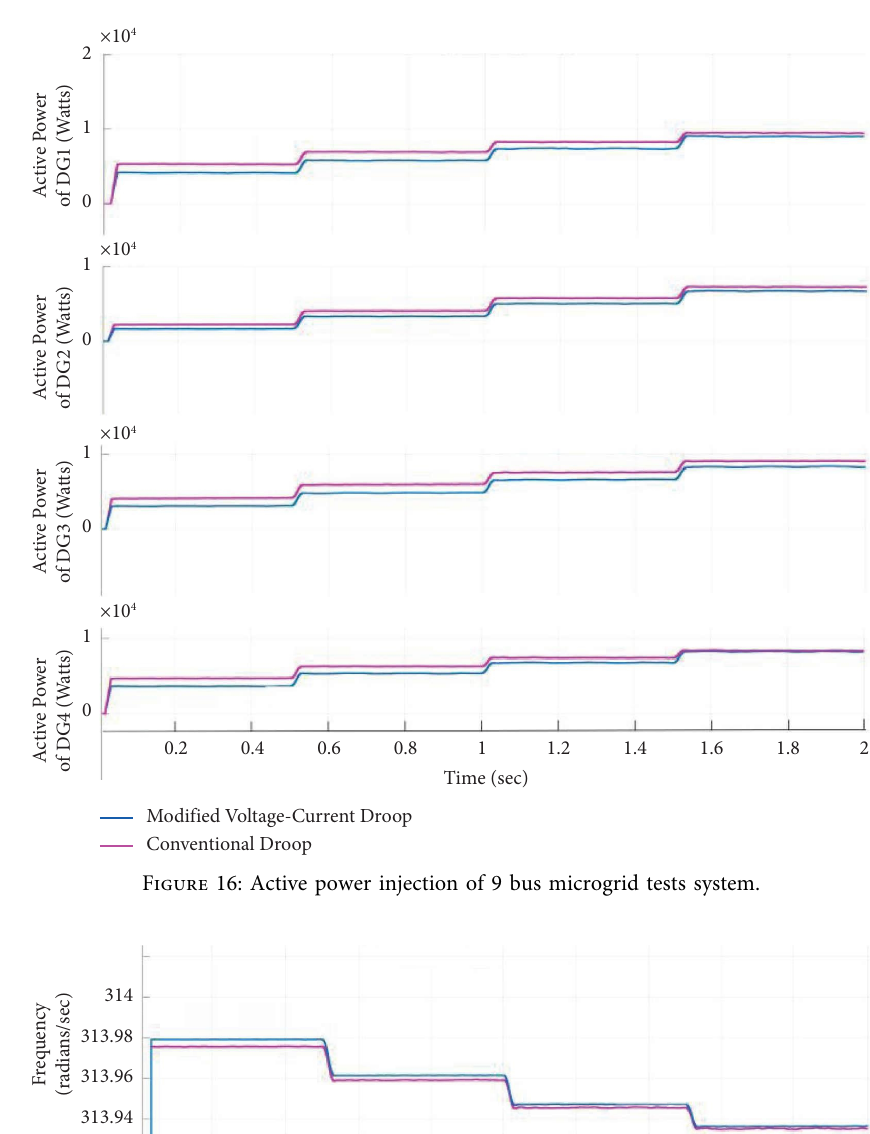
Figure 17: Representing frequency of 9-bus test